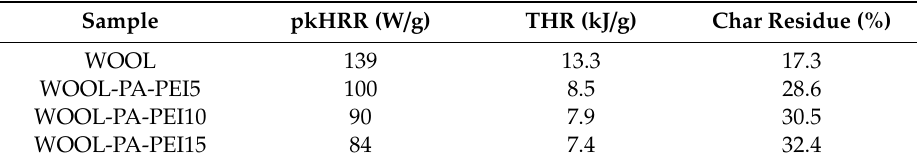
Table 18. Results from microscale combustion calorimetry for wool before and after the treatments with the polyelectrolyte